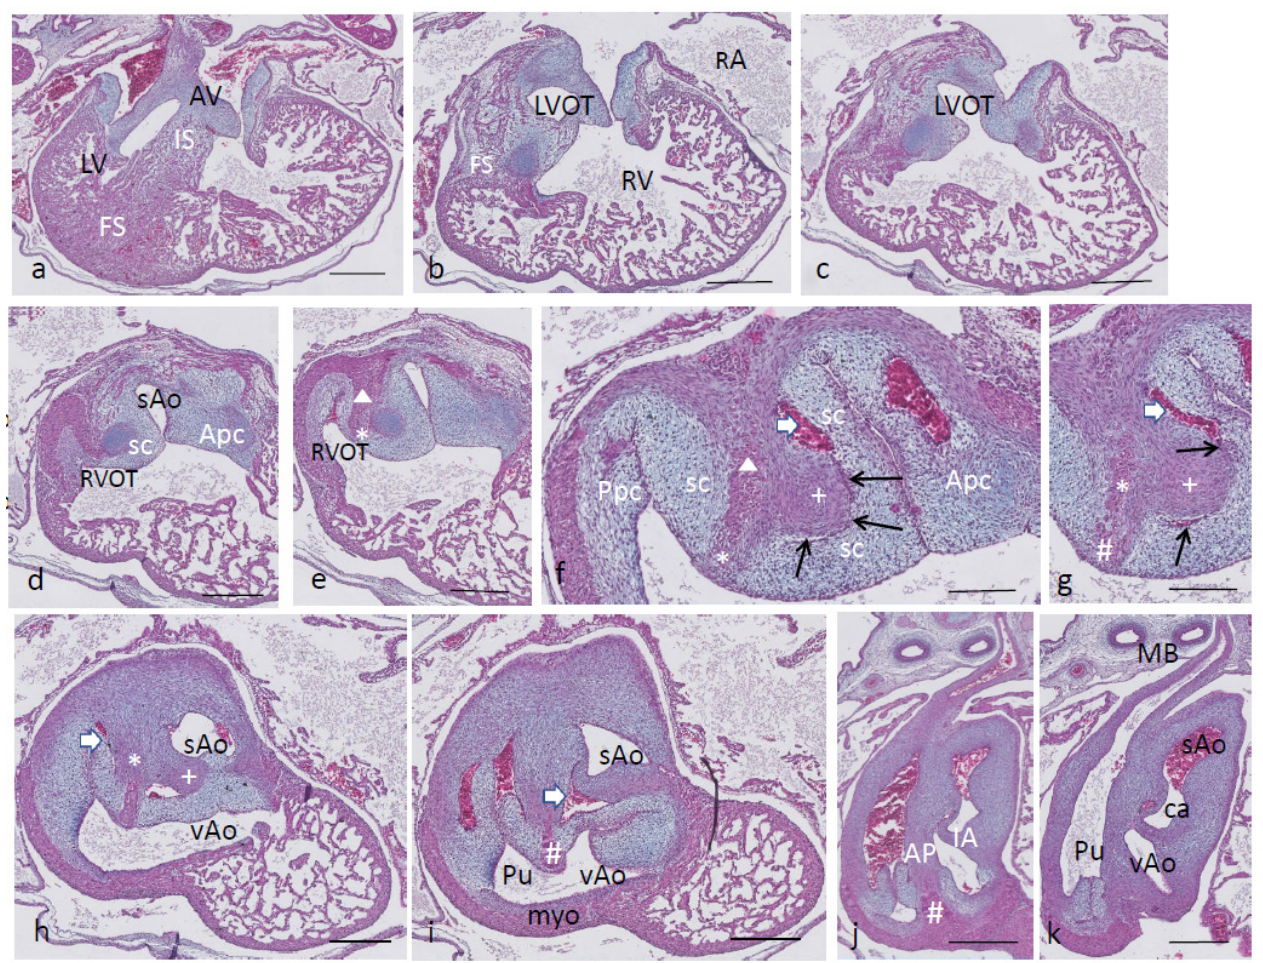
Figure 4. Ferguson stage 21, from AV canal to the arterial tree. Figure ( a ), the ventricular septum shows its two parts: the inlet septum attached to the central AV cushions and the more ventro-distally located folding septum. Figure ( b , c ), the septal cushion already showing cartilage differentiation (dark blue) located on the tip of the folding septum. Figure ( d , e ), the right ventricular outflow tract rotates to the right, displacing the folding septum ( Δ ) to the dorsal wall. Figure ( f , g ), the AP (*) and IA (+) streams of condensed mesenchyme are visible. The sinus of Valsalva (white arrow) and the tunnel of the foramen of Panizza (black arrows) are indicated. Figure ( h , i , j ), more distally, the AP and IA septa become completed by fusion of the septal cushion with the parietal cushion. Figure ( k ), branching of the arterial tree. Key to the symbols # ventral myocardium, part of AP septum; * (presumably) left-sided neural crest cells, part of AP septum; + (presumably) right-sided neural crest, part of IA septum; Δ dorsal myocardium, part of AP septum. Magnification Figure ( a – e , h – k ), bar 500 µm; ( f , g ), bar 200 µm.